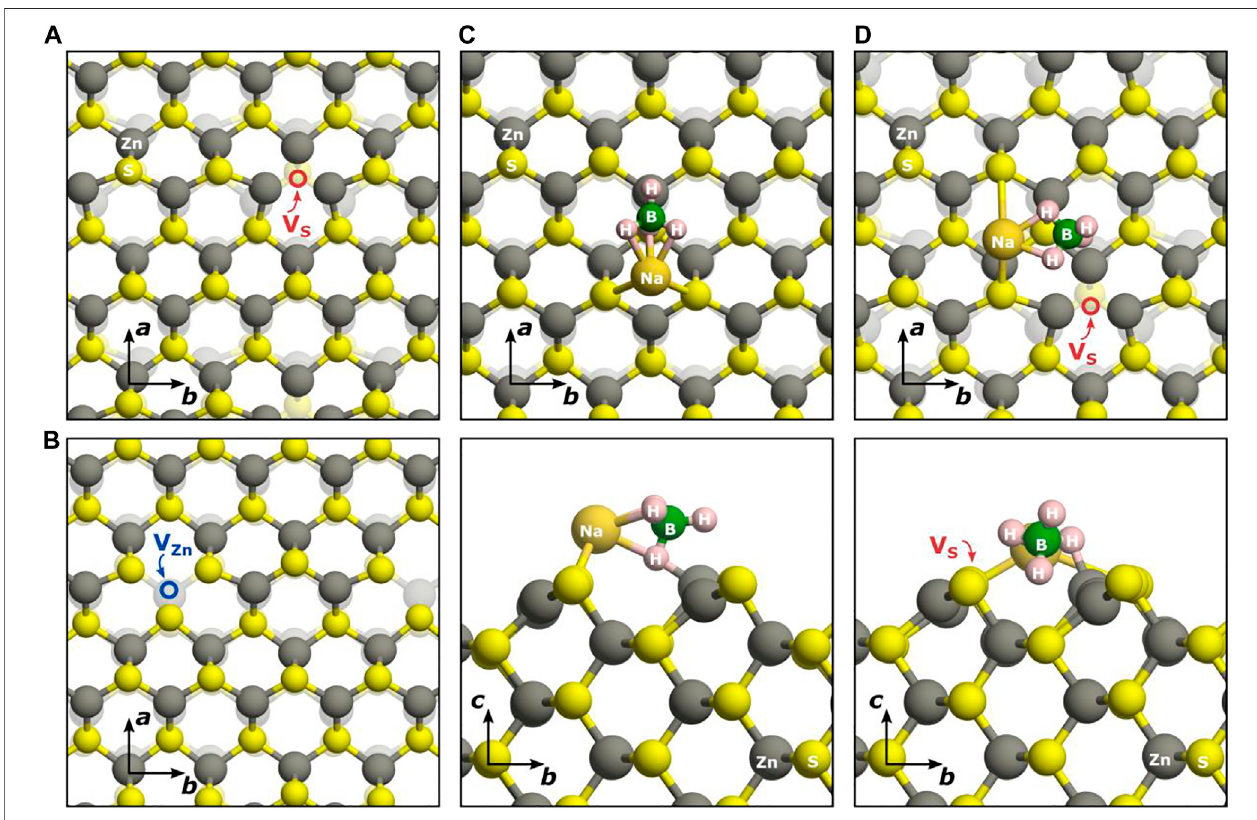
FIGURE 8 | Crystal structure of defects and adsorbates at the ZnS (220) surface: single sulphur vacancy (A) , single zinc vacancy (B) , adsorption of NaBH 4 on the pristine (220) surface (C) , adsorption of NaBH 4 on a (220) surface where a single sulphur vacancy is present (D) .